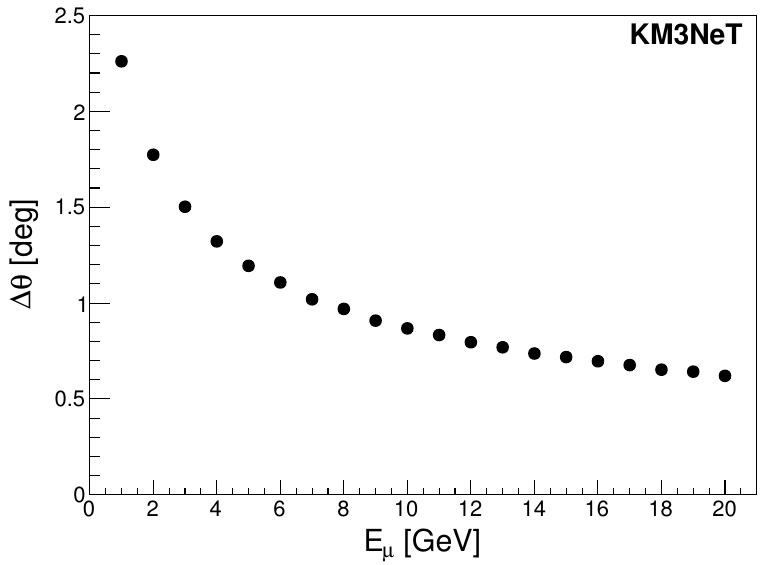
Figure 24 . Limiting resolutions on muon direction reconstruction (68% quantiles) as a function of muon energy E (cid:22) .